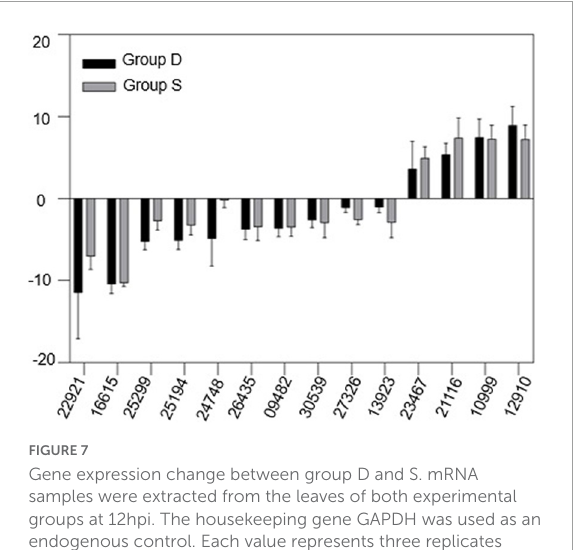
FIGURE7 Gene expression change between group D and S. mRNA samples were extracted from the leaves of both experimental groups at 12hpi. The housekeeping gene GAPDH was used as an endogenous control. Each value represents three replicates mean ± standard deviation